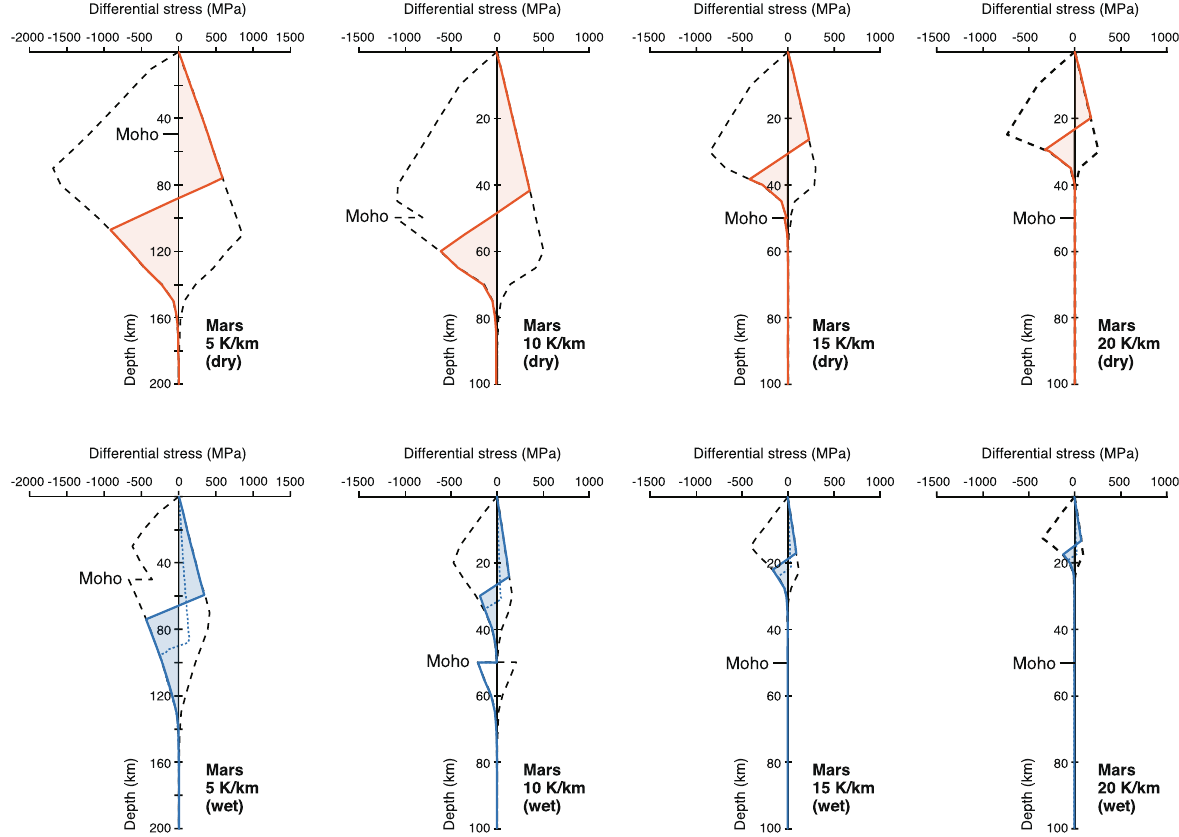
Fig. 7 Strength profiles for Mars with variable thermal gradients under dry (upper panel) and wet (lower panel) conditions. Dotted lines in the lower panels indicate brittle strength calculated in the presence of clay minerals. Calculation parameters are the same as those for Fig.